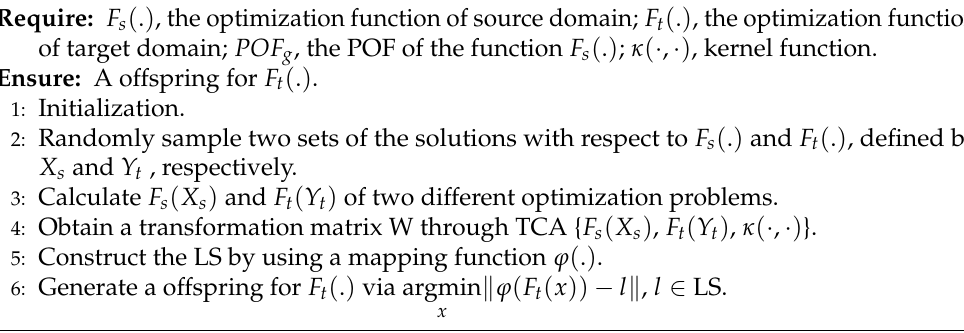
Algorithm 2 Framework of